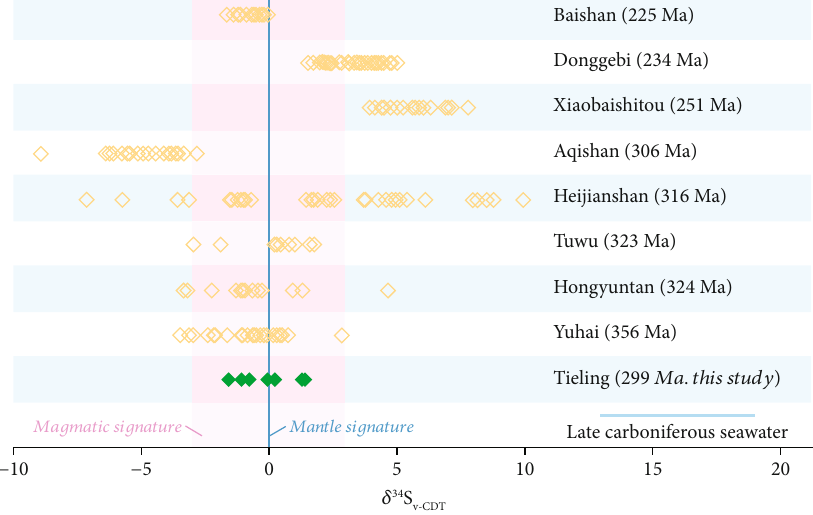
Figure 12: δ 34 S values of ore-forming fl uids at Tieling and other major deposits in eastern Tianshan. Sulfur isotopic compositions of V-CDT global seawater in the Late Carboniferous were modi fi ed after Holser [63]. Sulfur isotopic compositions of representative deposits were modi fi ed after Han et al. [14], Wang et al. [16], Zhang et al. [25], Sun et al. [39], Zhang et al. [54], Wang et al. [56], Dai et al. [61], and Zhao et al. [62].